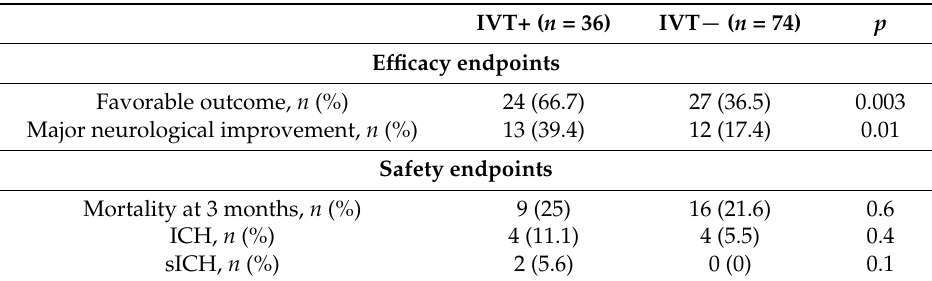
Table 3. Efficacy and safety endpoints.